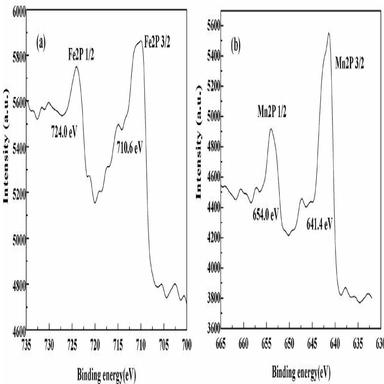
XPS spectra of Fe 2p (a) and Mn 2p (b).